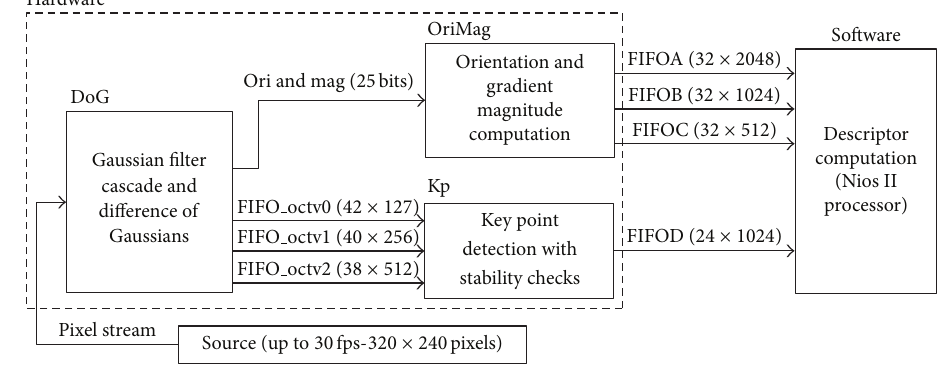
Figure 2: A hardware/software embedded system codesign comprising of three hardware blocks to extract features from images and precompute data for the descriptors and one software block to associate descriptors with features; the blocks communicate via dedicated channels along with FIFOs to store temporary data while receiver blocks are busy